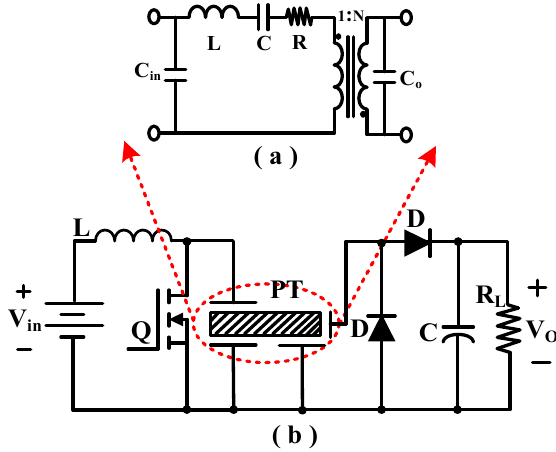
Figure 19. ( a ) Piezoelectric transformer equivalent circuit. ( b ) Class “E” power amplifier topology. Figure 19. (a) Piezoelectric transformer equivalent circuit. (b) Class “E” power amplifier topology.